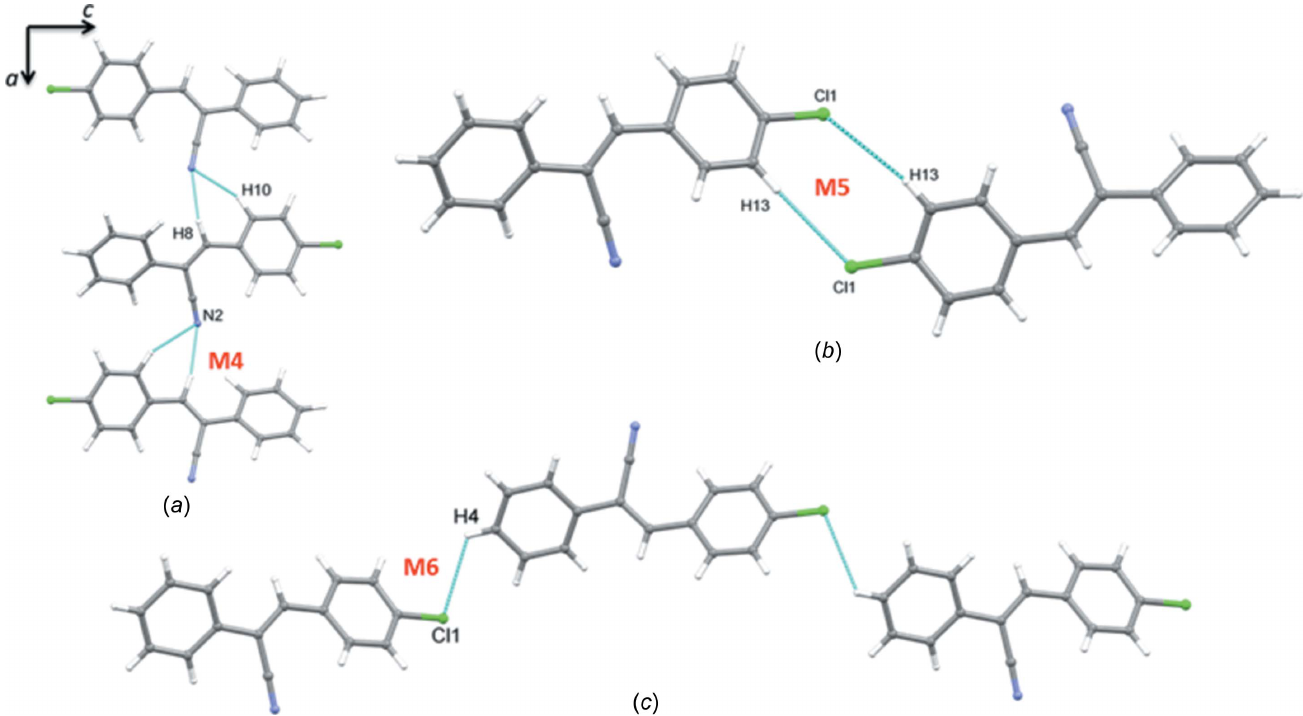
Figure 5 ( a ) The molecular chain formed by three-centred C—H (cid:2)(cid:2)(cid:2) N interactions, ( b ) a closed molecular dimer generated by intermolecular C—H (cid:2)(cid:2)(cid:2) Cl interactions and ( c ) a C (12) chain formed by intermolecular C—H (cid:2)(cid:2)(cid:2) Cl